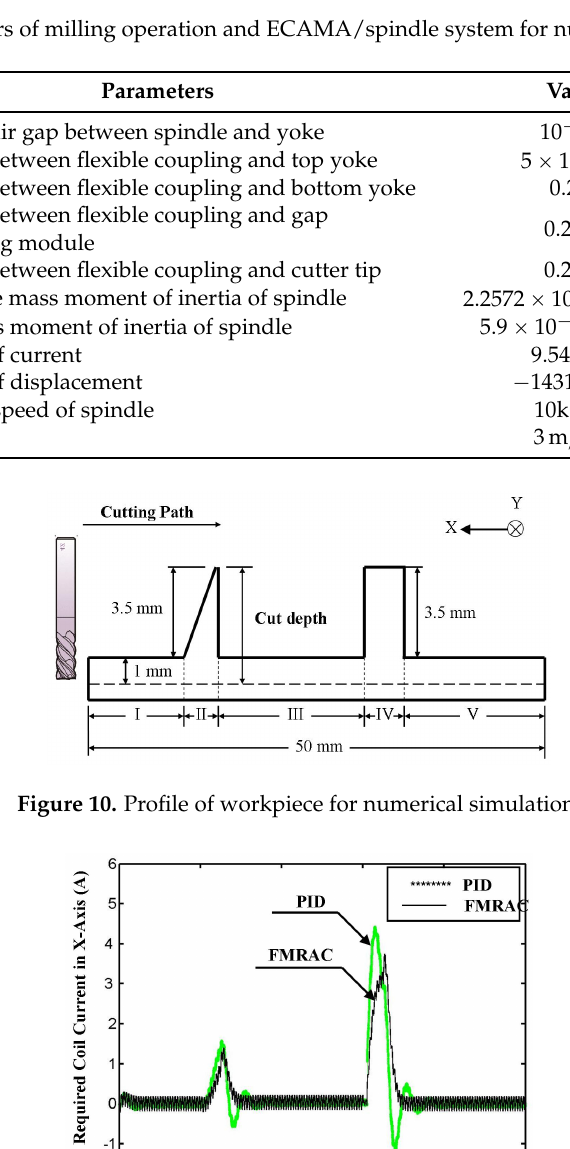
Figure 12. Comparison of required coil current for ECAMA in the Y -axis under various control laws. Figure 13. Spindle position deviation in the X -axis under various control laws.